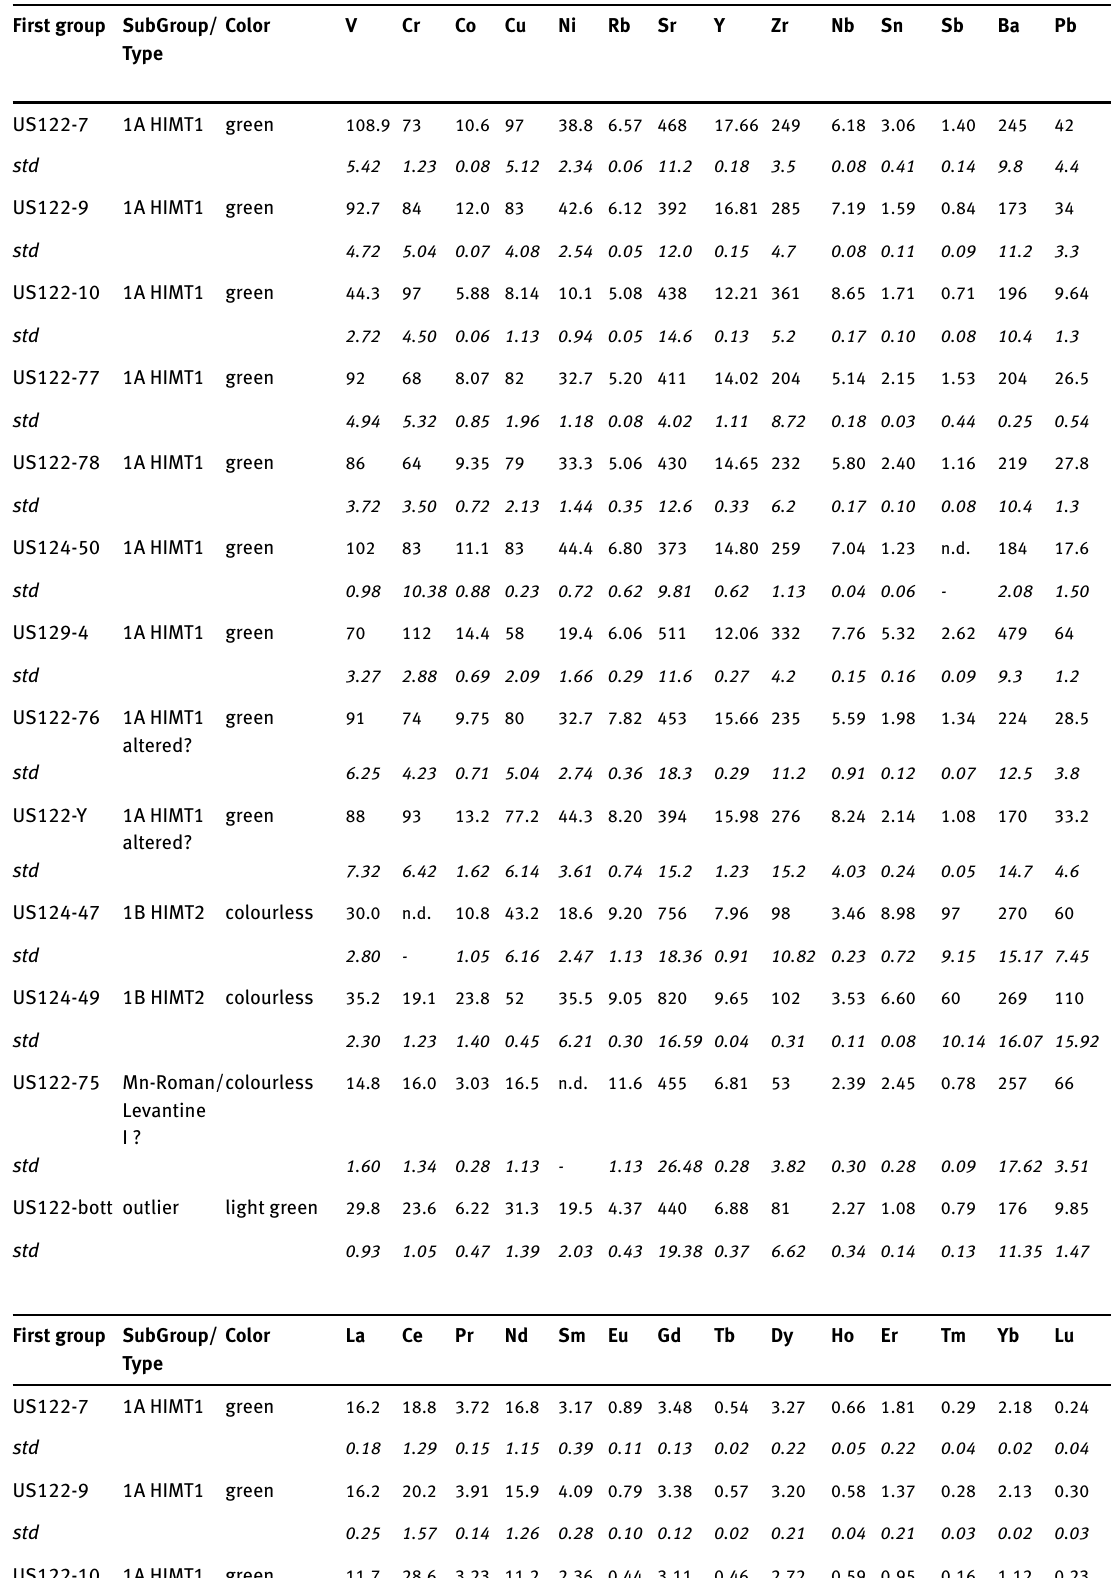
Table 4: Trace element concentrations in ppm determined by LA-ICP-MS. First group